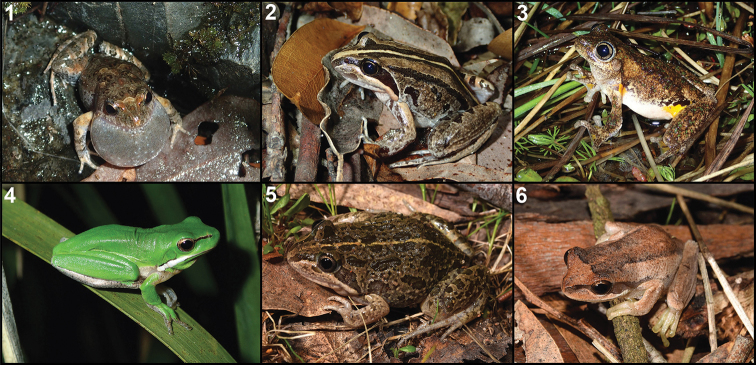
Photographs of the top six species recorded in the first year FrogID. 1Crinia
signifera2Limnodynastes
peronii3Litoria
peronii4Litoria
fallax5Limnodynastes
tasmaniensis6Litoria
ewingii.